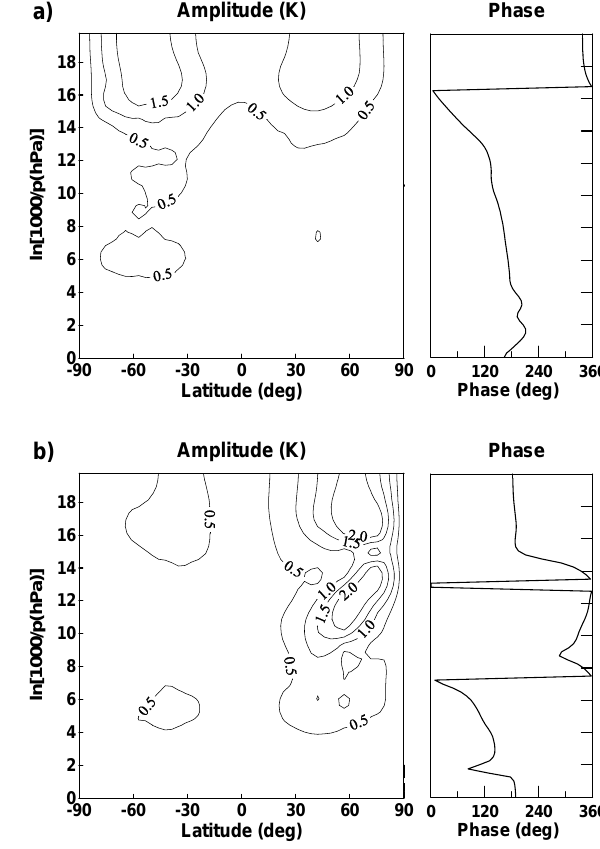
Fig. 4. Latitude-height distribution of amplitude (left) and phase (right) of temperature perturbations for the ultra-fast Kelvin wave for 16 March ( a ) and 1 July ( b ) . The phases are shown at the equa- tor.